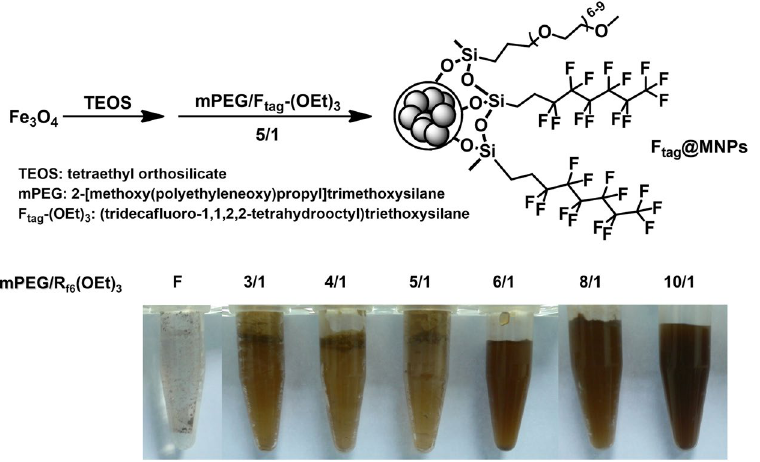
Figure 3. Preparation of the F tag @MNPs. The particle surface was functionalized by a sol-gel process using TEOS with mPEG and a fluorous silane. Various ratios of mPEG to fluorous silane were tested (3:1, 4:1, 5:1, 6:1, 8:1, and 10:1) to find an optimal ratio that is soluble in buffer